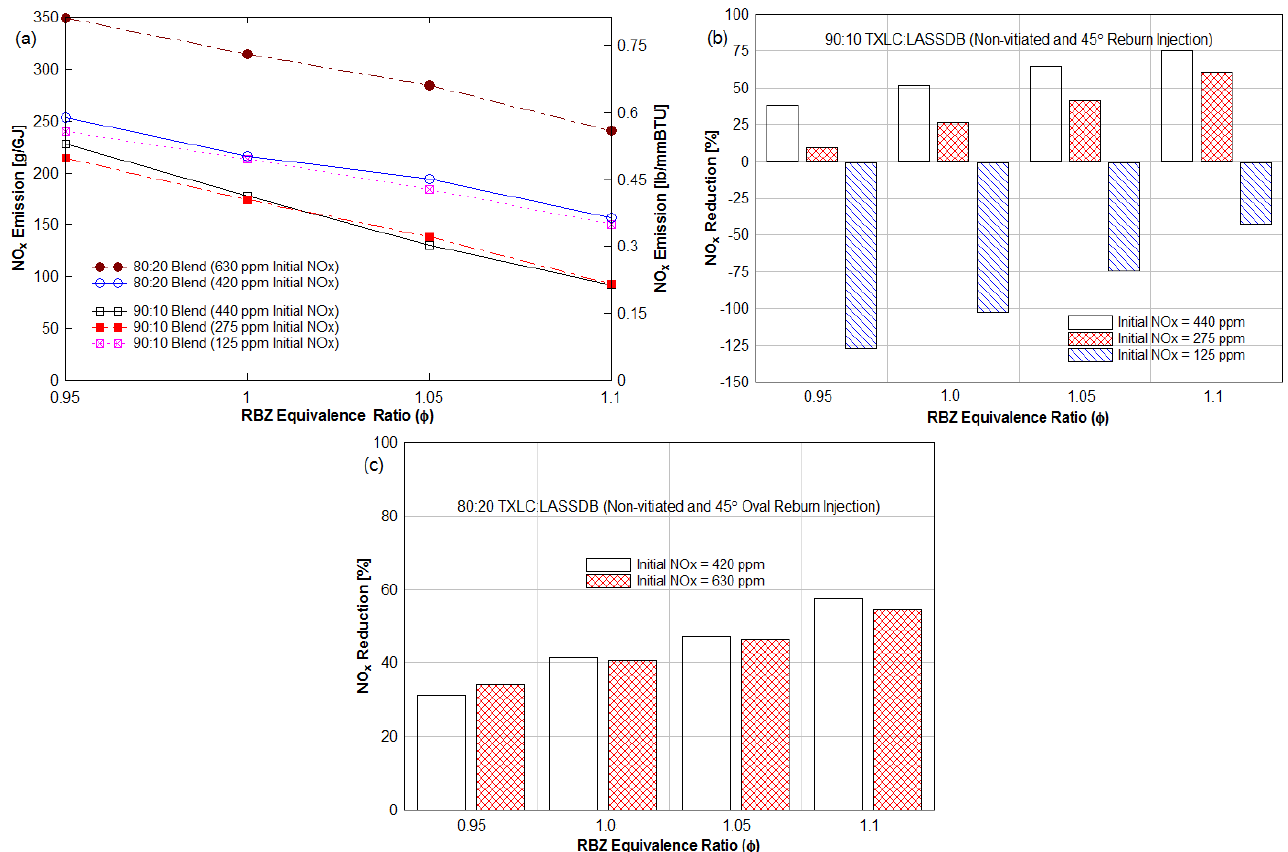
Figure 12. Effect of the initial NO x produced by primary fuel combustion (non-vitiation, 30% heat input and 45° injection): ( a ) NO x emissions (90:10 blends for the circular injection and 80:20 blends for the oval injection (with oval shaped nozzle)), ( b ) NO x reductions for 90:10 blends and ( c ) NO x reductions for 80:20 blends.